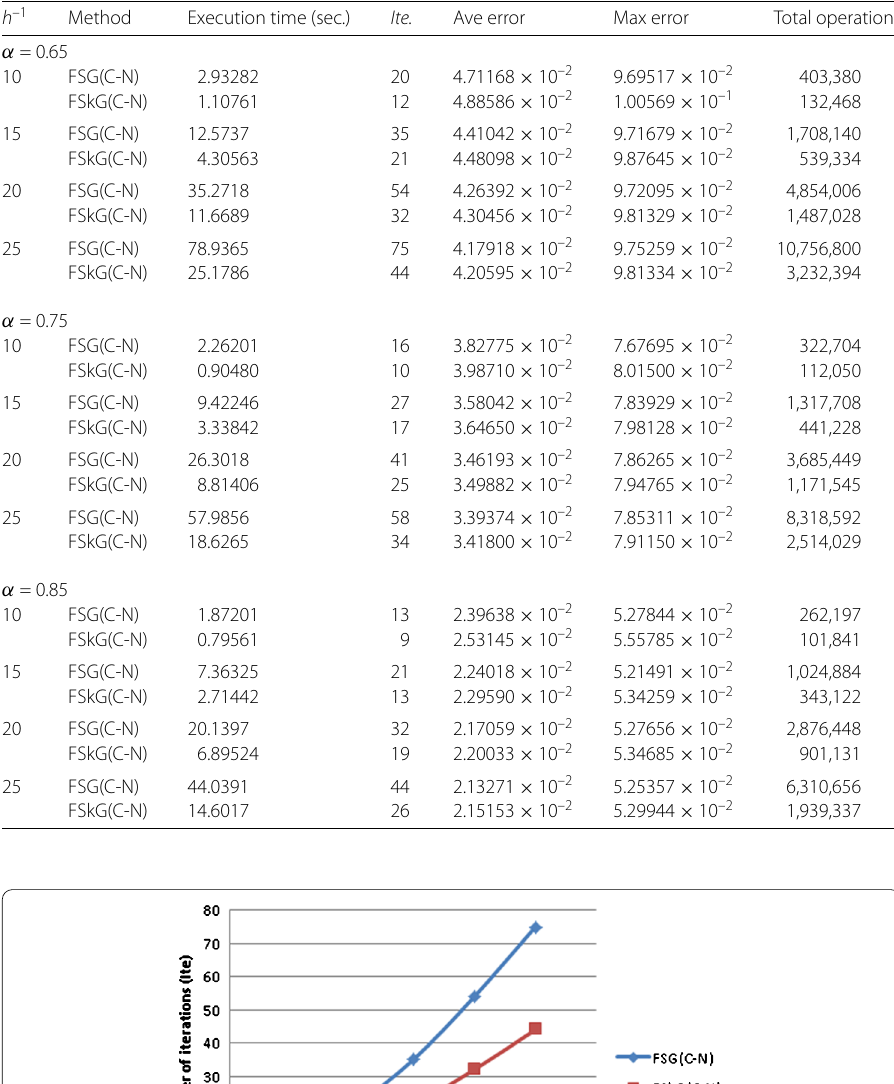
Table 4 Comparison between FSG(C-N) and FSkG(C-N) iterative methods at τ = 1/10 for Example 1